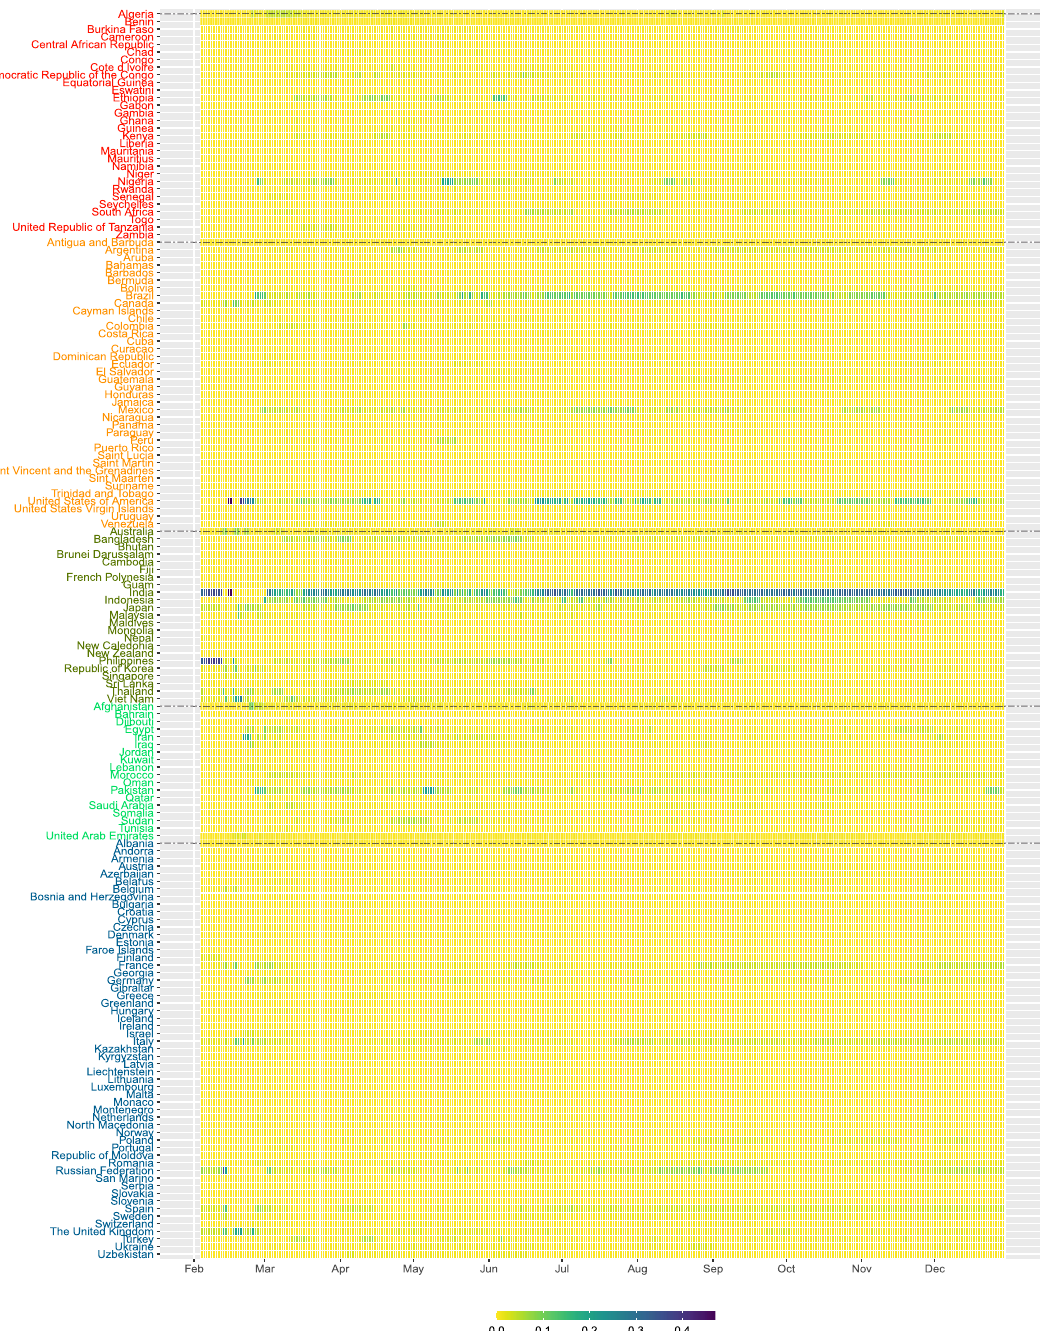
from the two countries to interact. So the risk contribution f it is like doing ‘stress testing’ of the pandemic risk. In early February, the risk score is mainly contributed by Asia, where the risk contributions from India and Philippines are around 0.3. From late February to early March, the risk score from non-Asian region, e.g. United States from America, Iran and Pakistan from Eastern Mediterranean, and Italy, Germany and France from Europe started showing significant contributions to the risk score. In particular, f it of the United States has been quite high since mid February, signifying the early stage of the pandemic in the country. In late May and June, Ethiopia, Nigera from Africa, and Brazil from America also showed around 0.1 contribution that should be alerted. The risk contribution f it of the India, Indonesia, Japan in Asia, Brazil and the United States in America, and France, Italy and Russia in Europe are quite relatively high in July to November 2020.